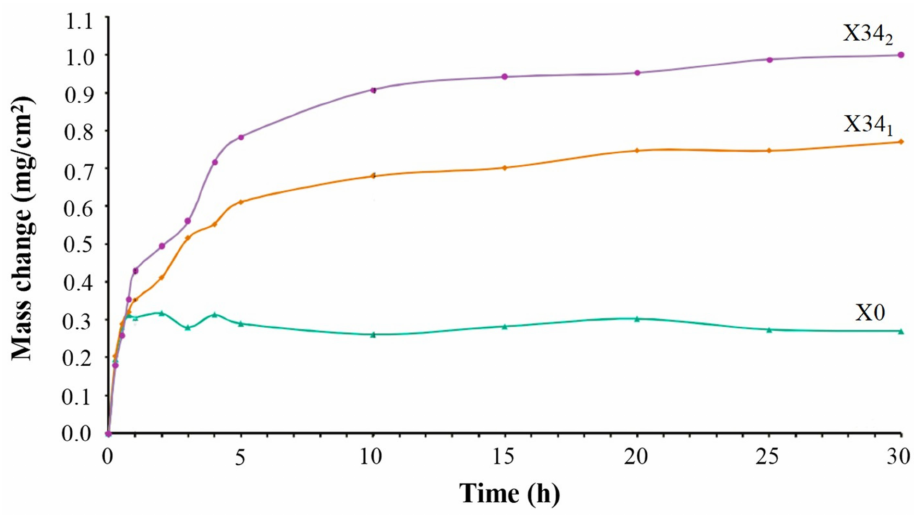
Figure 4. Kinetic curves of the samples oxidized at 1200 ◦ C. Reproduced with permission [96]. Copyright 2019